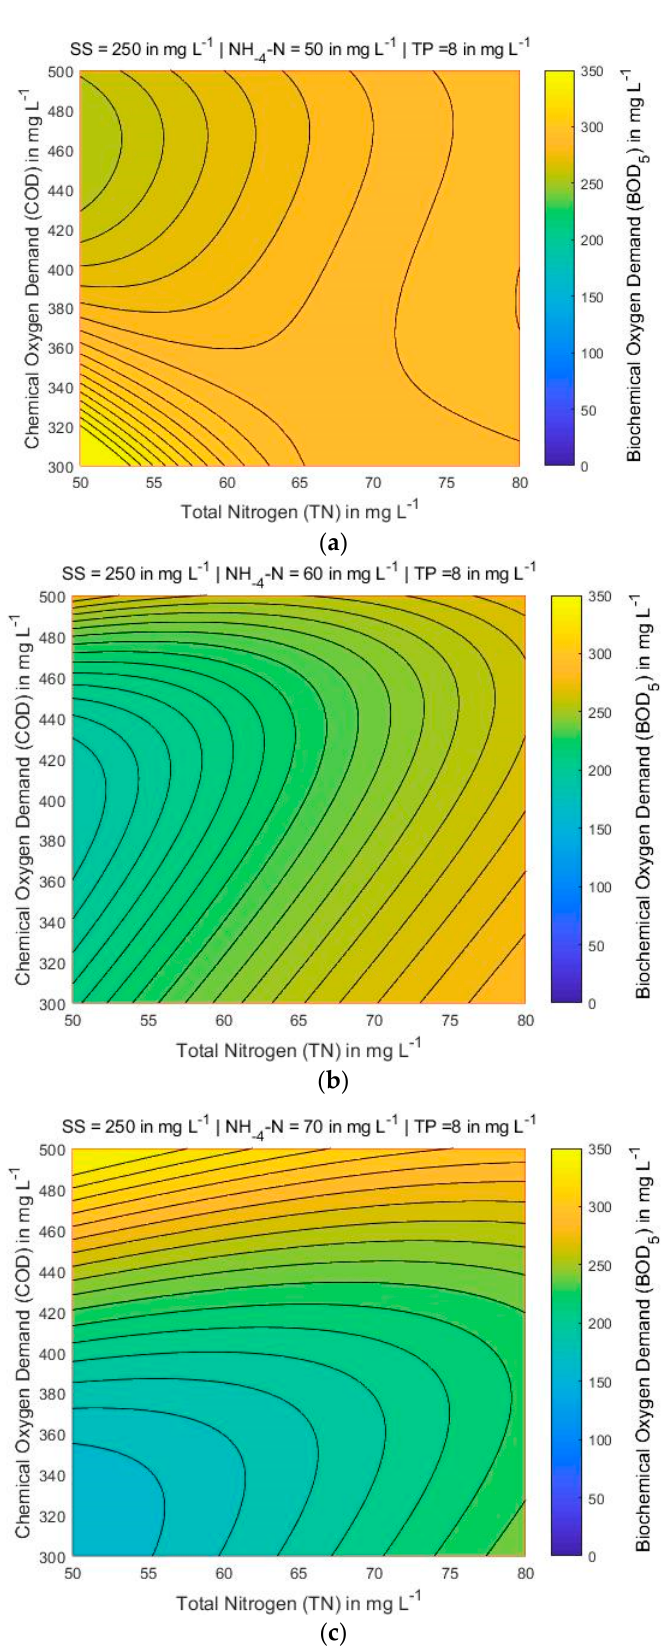
Figure 7. BOD 5 contour maps for three different values of SS (in mg L − 1 ) while NH 4 -N = 60 mg L − 1 and TP = 8 mg L − 1 are constant: ( a ) SS = 200; ( b ) SS = 250; and ( c ) SS= 300.